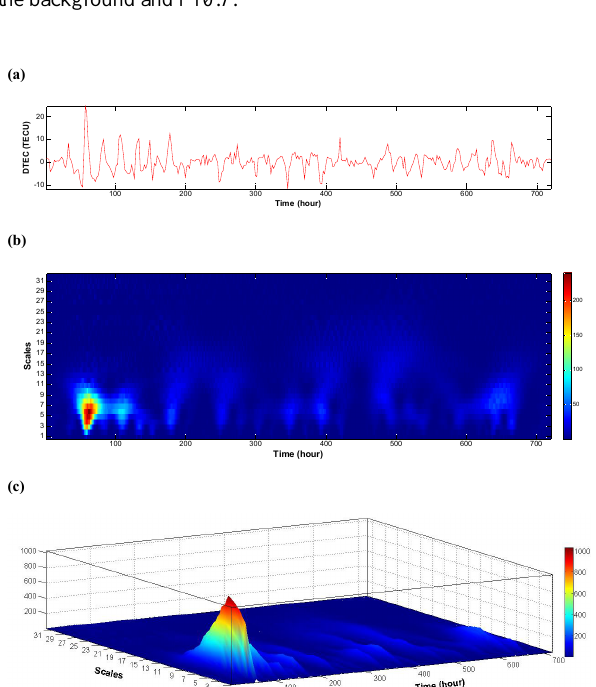
Fig. 6. (a) The DTEC time series right over the epicenter (30.3 ◦ N, 103.0 ◦ E) of the Ya’an earthquake from 22 March 2013 to Figure 6. (a) The DTEC time series right over the epicenter (30.3° N, 103.0° E) of the Ya’an 20 April 2013. (b) The analytic wavelet energy density spectrum earthquake from 22 March 2013 to 20 April 2013. (b) The analytic wavelet energy density of DTEC using fbsp2-1-0.5 wavelet. (c) The 3-D coefficient plots spectrum of DTEC using fbsp2-1-0.5 wavelet. (c) The 3D coefficient plots of the analytic of the analytic wavelet energy density wavelet energy density spectrum.